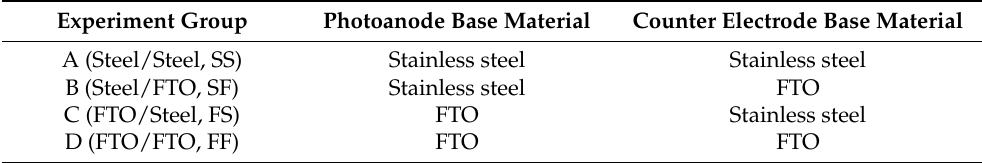
Table 1. Four experiment groups with different electrode combination.